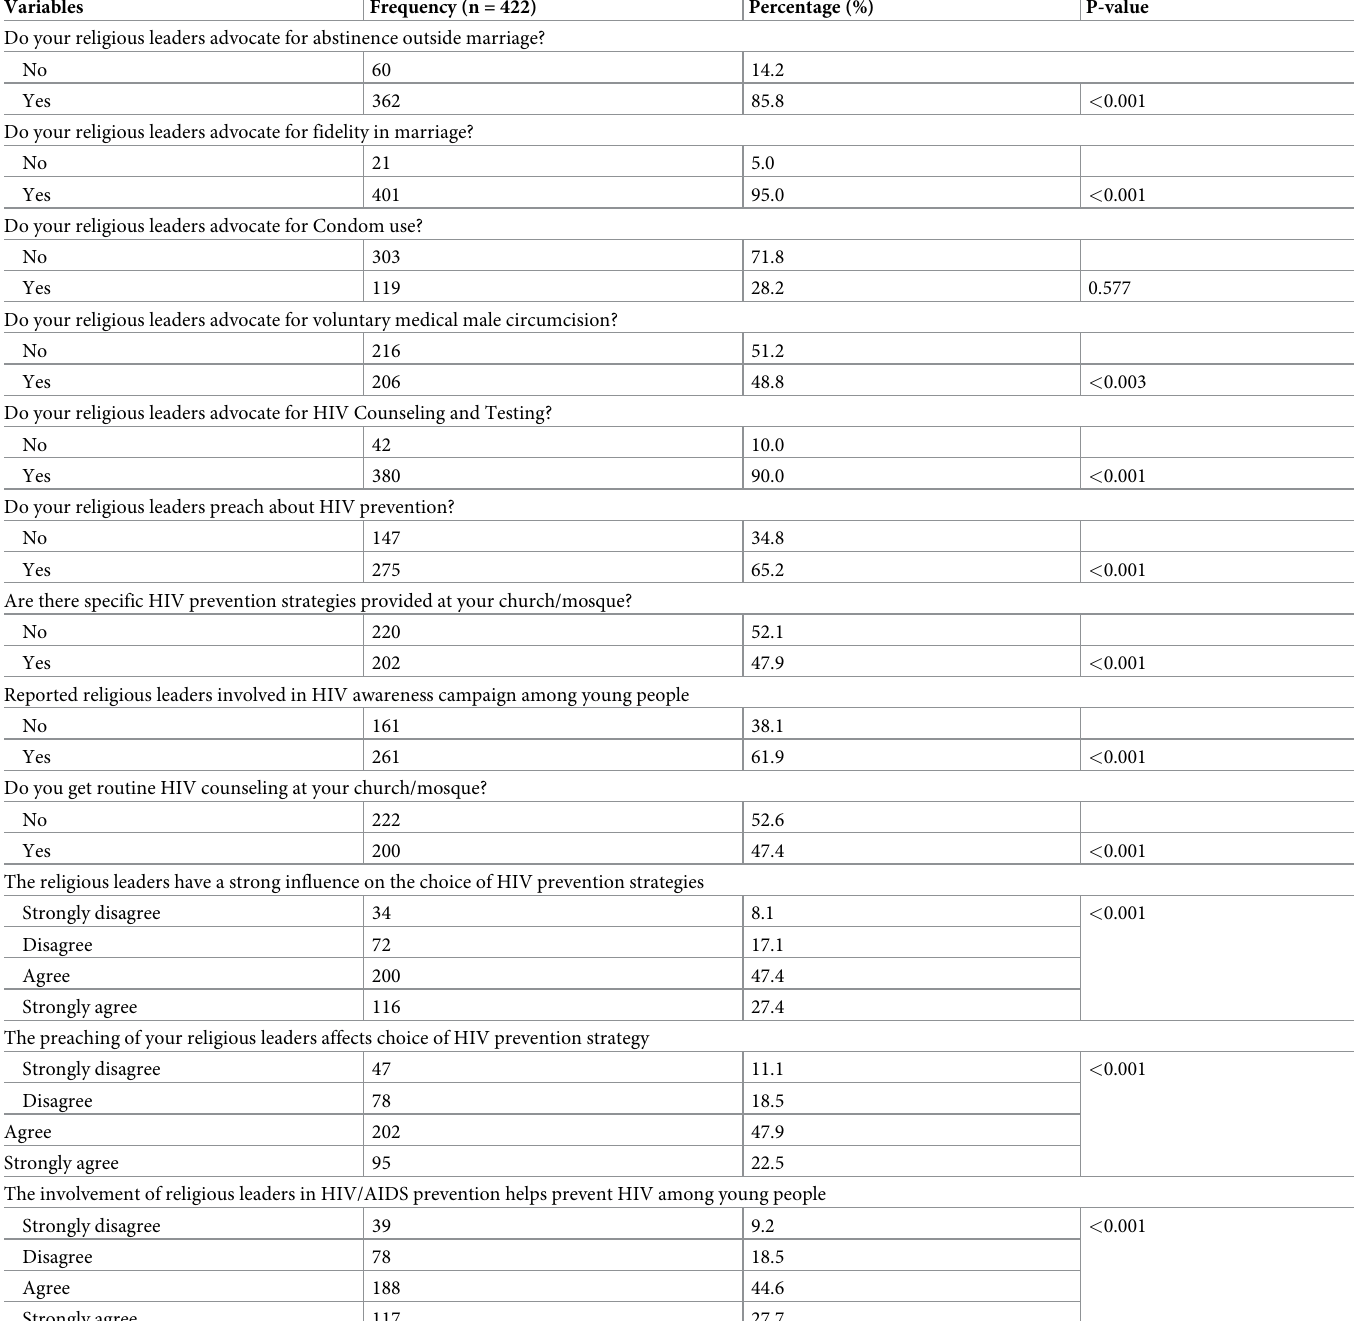
Table 2. Perceptions and HIV prevention strategies provided by religious